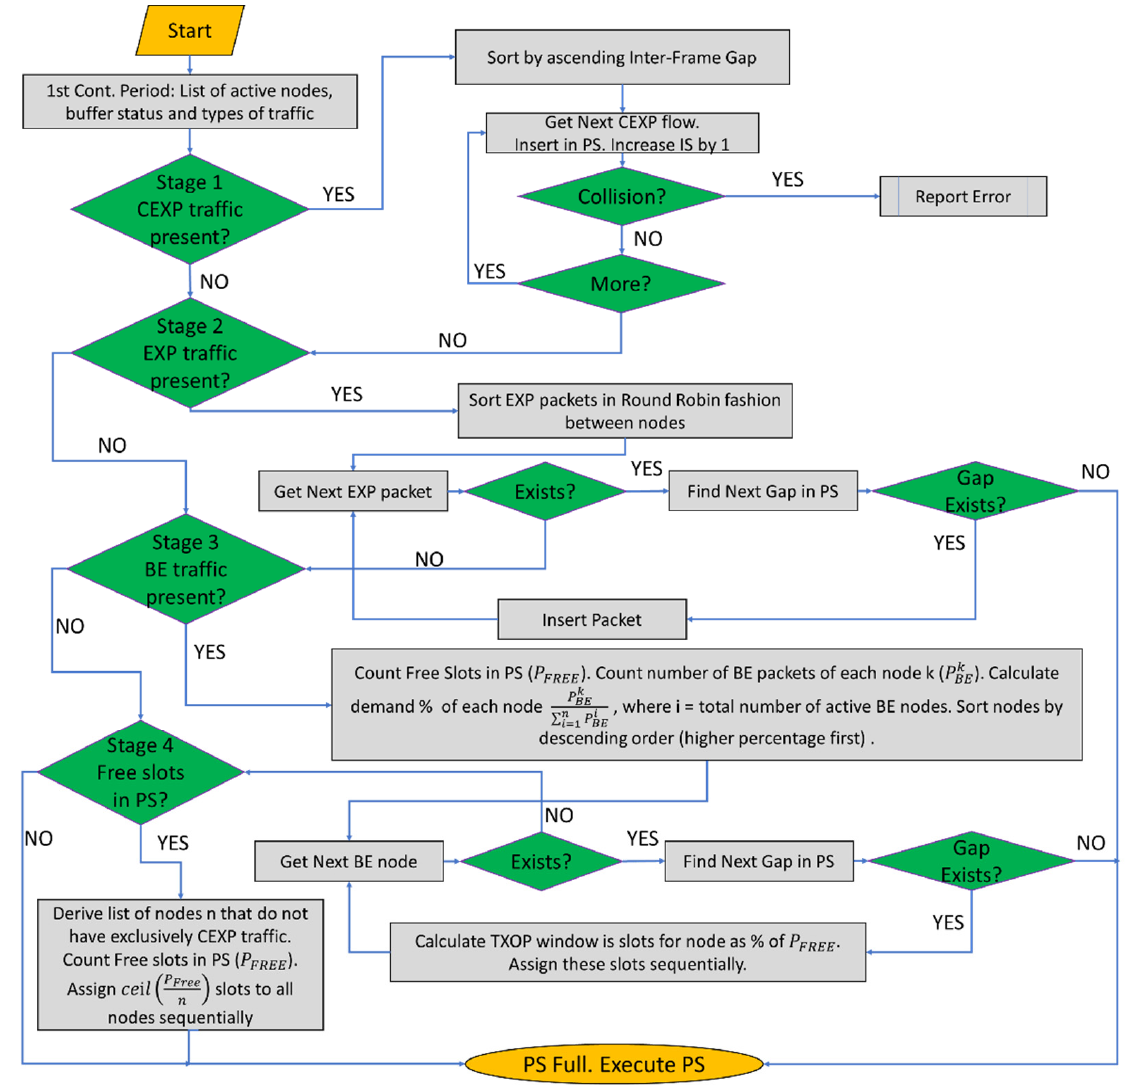
Figure 4. Polling Sequence creation algorithm for qMT-MAC.